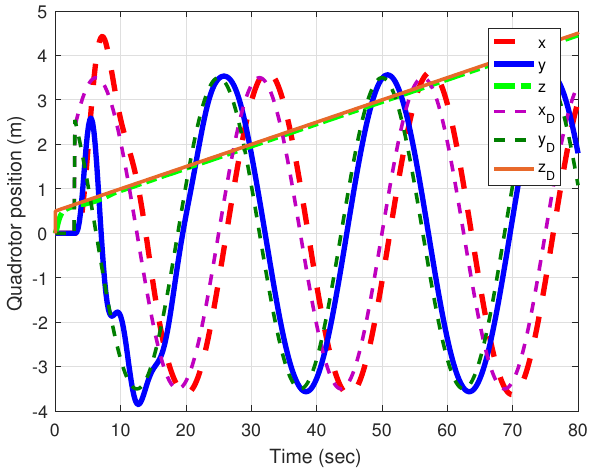
Figure 10. Quadrotor position.